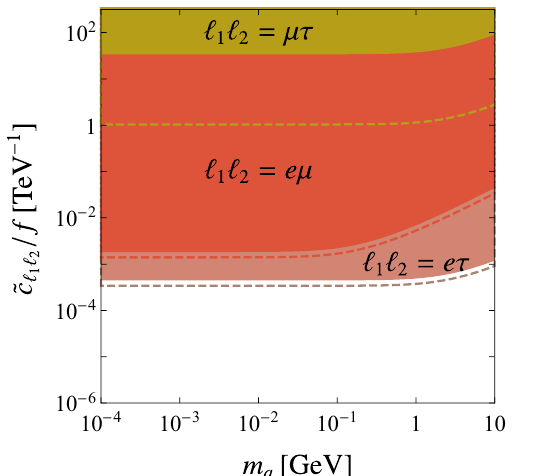
q (cid:1) , assuming also Im (cid:0) [ k ] ∗ [ k ] ≡ E e ‘ 2 ‘ 1 ‘ 2 ‘ 1 1 ‘ 2 = c = c = 1 TeV − 1 and all other Wilson ee /f µµ /f ττ /f and ˜ c are derived from the eEDM, the one on ˜ c eµ eτ